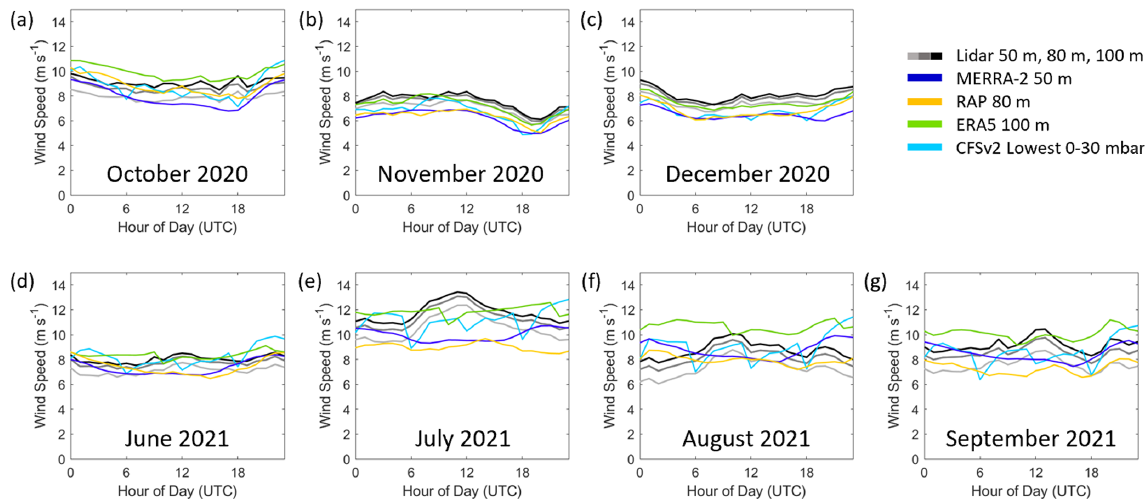
Figure 14. Observed and modeled diurnal trends in wind speed at Humboldt according to month.